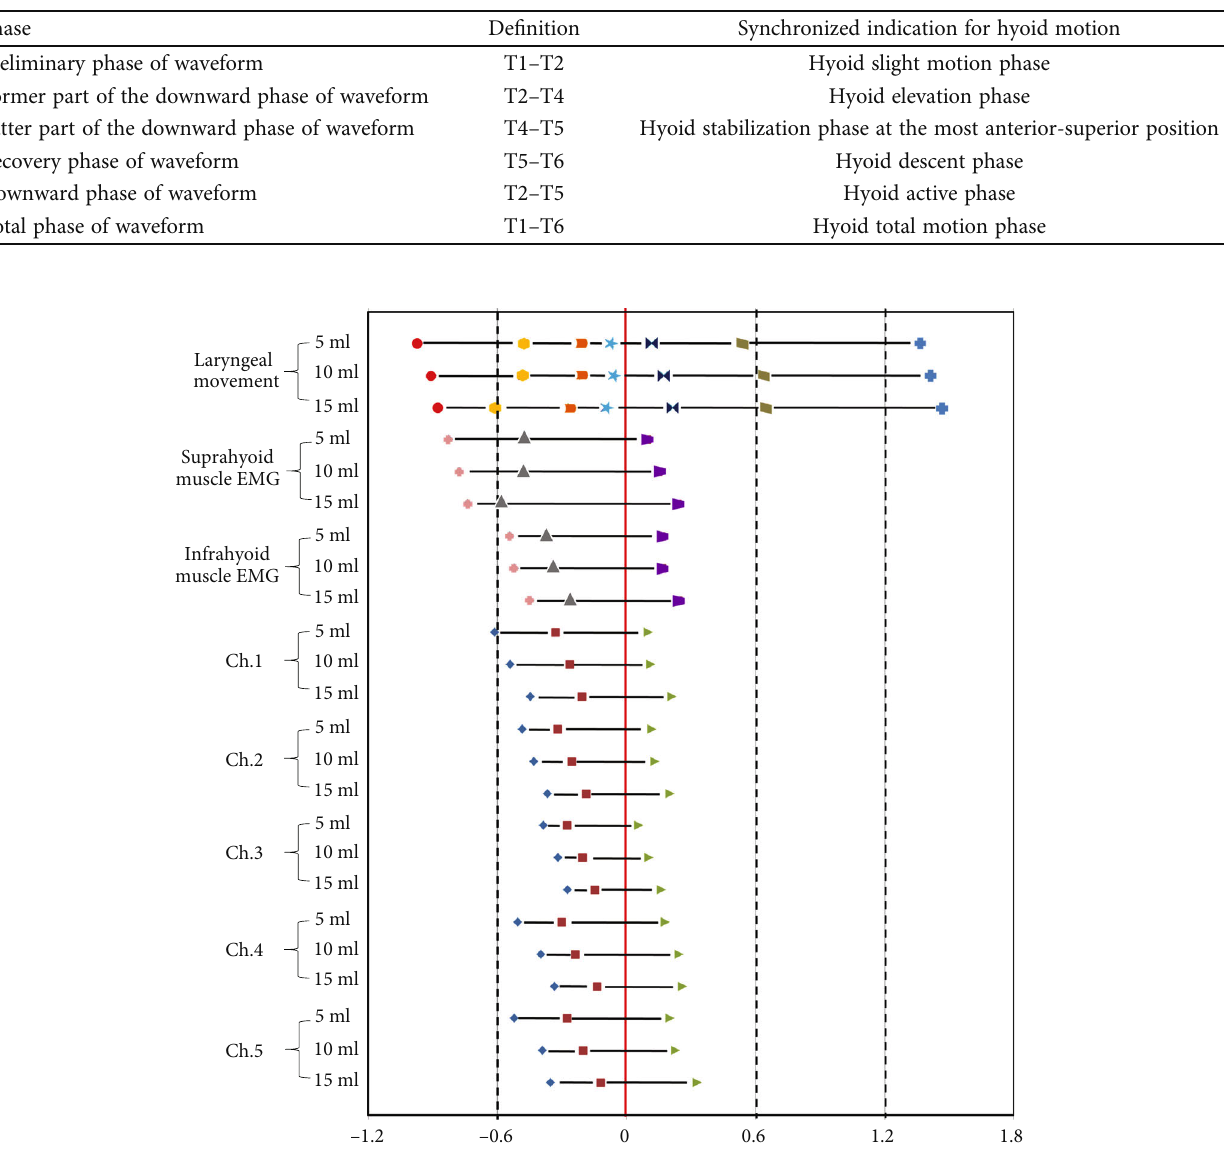
Table 2: De fi nitions of phases on the laryngeal signal waveform recorded by the bend sensor.